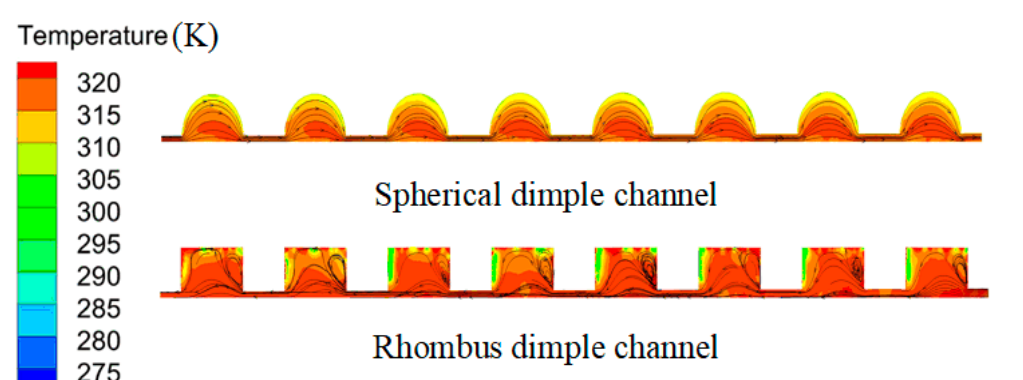
Figure 17. Comparisons of fluid temperature over the different dimpled channel Re = 10,000.